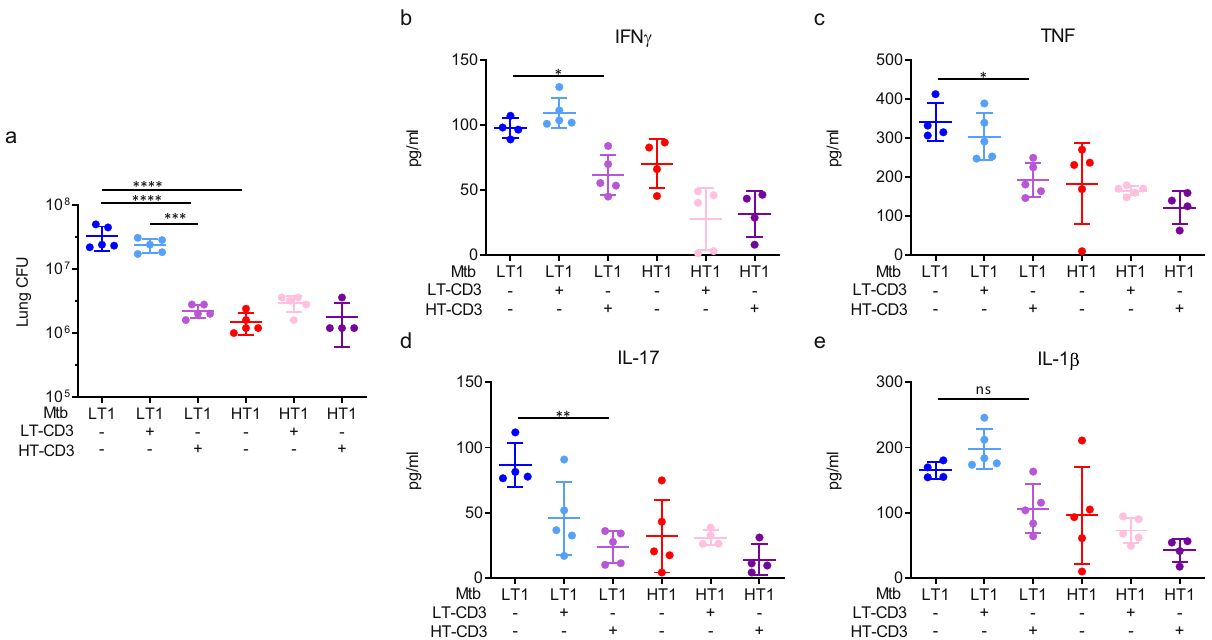
Fig. 5 Effector T cells from Mtb-HT infected mice reduce bacterial burden and in fl ammation in Mtb-LT infected mice. Three days prior to infection naïve mice were retro-orbitally injected with PBS or 2 × 10 6 CD3 + T cells isolated from 6 to 7-week Mtb-LT1 or Mtb-HT1 infected mice. On the day of infection, half of the mice in each group were infected with Mtb-HT1 and the other half with Mtb-LT1 via Glas-Col aerosol exposure. At 11 weeks post-infection, lung bacterial burden was determined and presented as CFU ( a ) and protein levels of IFN γ ( b ), TNF ( c ), IL-17 ( d ), and IL-1 β ( e ) was measured in lung lysates by ELISA. Data are presented as mean values + / − SD. Source data are provided as a Source Data fi le. Sample size of n = 5 mice was included in each group. Signi fi cance was determined using one-way ANOVA with Tukey ’ s correction * P = 0.0421 (IFN γ panel b ), ** P = 0.0013 (IL-17, panel c ) * P = 0.0132 (TNF, panel b ), *** P < 0.001, **** P < 0.0001. The experiment was repeated with Mtb-HT2 and Mtb-LT2.